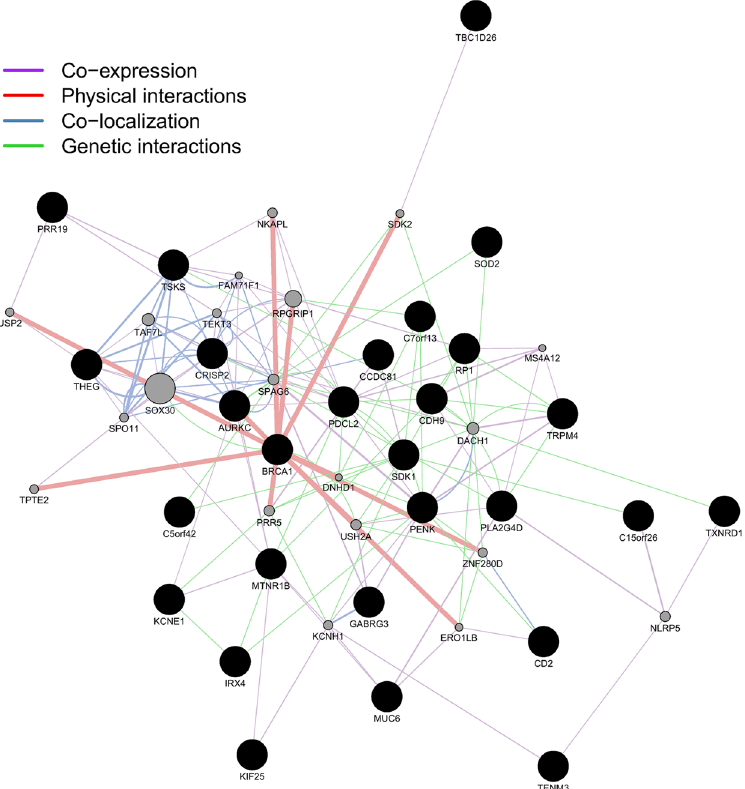
Figure 6. GeneMANIA network of the 34 sig-DMRs not affected by age or cell type composition and consistently differentially methylated in both blood and plaque tissue.